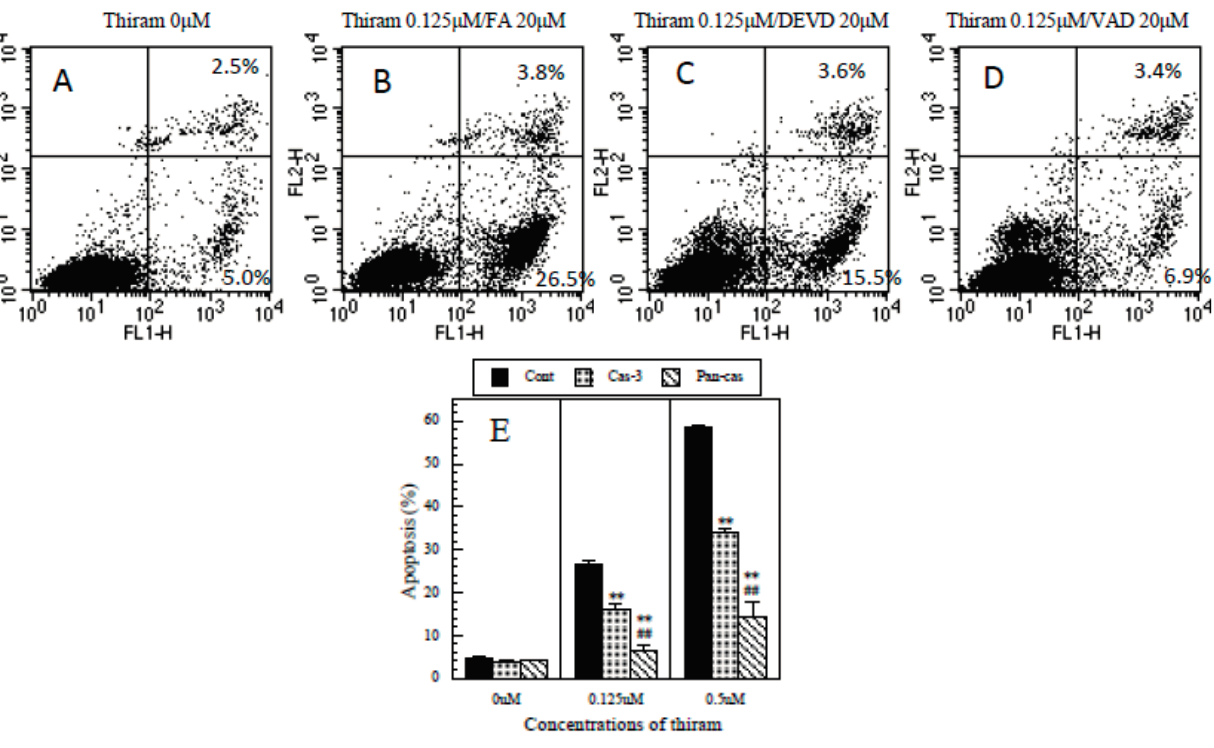
Figure 6. Protective effects of caspase-3 and general caspase inhibitors on